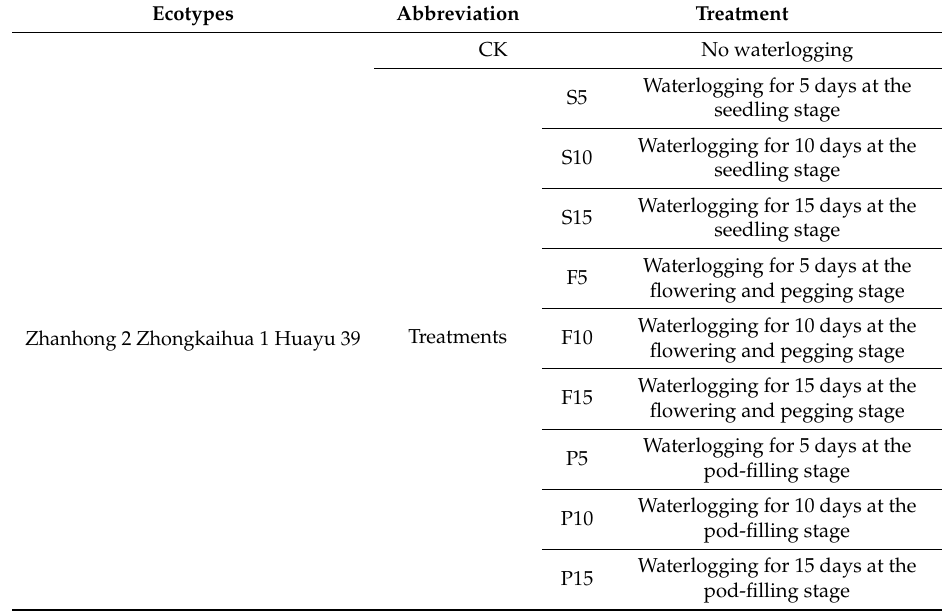
Table 2. Experimental